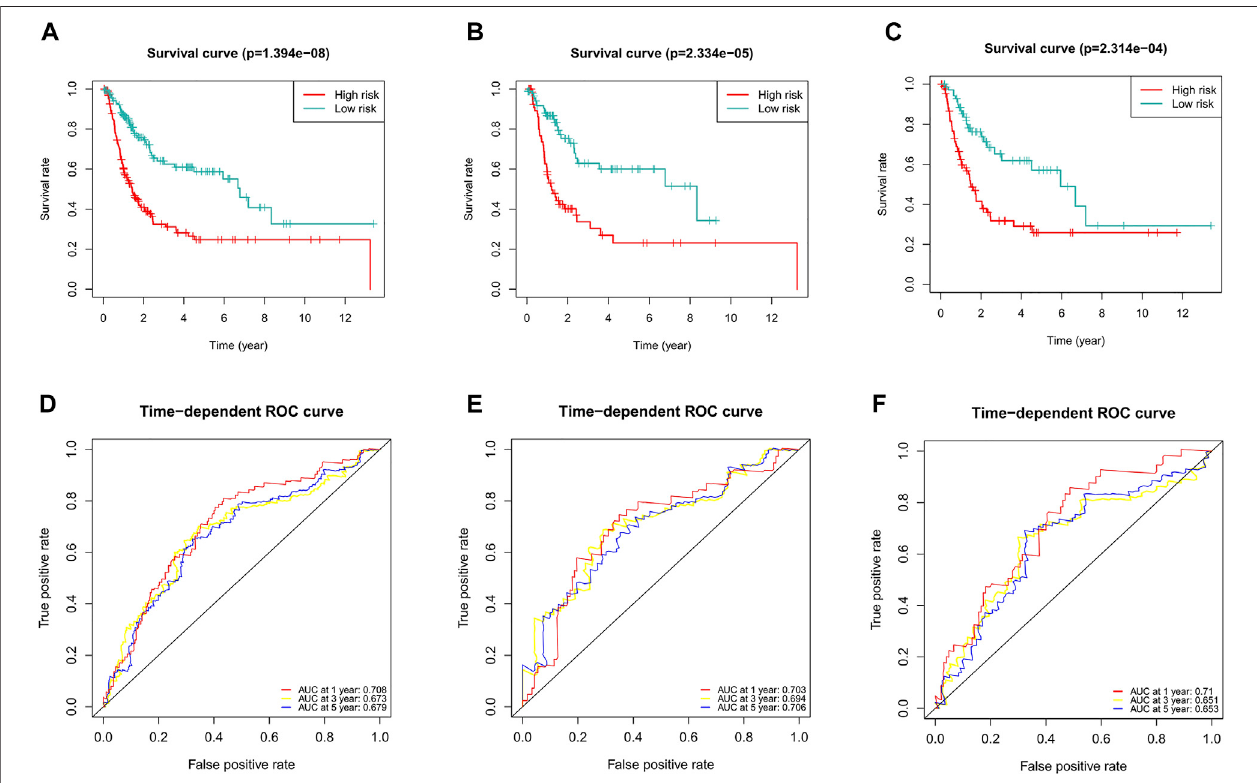
FIGURE11| Evaluationofthepredictivevalueoftheferroptosis-relatedlncRNAsignatureforDFS. (A) Kaplan-Meiersurvivalcurveintheentiredataset. (B) Kaplan- Meiersurvivalcurveinthe fi rstcohort. (C) Kaplan-Meiersurvivalcurveinthesecondcohort. (D) ROCcurveandAUCsat1-year,3-yearsand5-yearssurvivalintheentire dataset. (E) ROC curve and AUCs at 1-year, 3-years and 5-years survival in the fi rst cohort. (F) ROC curve and AUCs at 1-year, 3-years and 5-years survival in the second cohort. lncRNAs, long noncoding RNAs; DFS, disease-free survival; ROC, receiver operating characteristic; AUC, area under the curve.